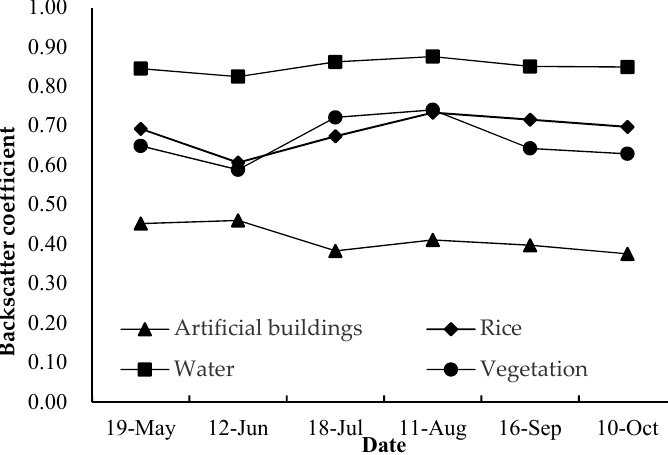
Figure 17. Sentinel-1 VV/VH polarization backscatter coefficient of ground objects.